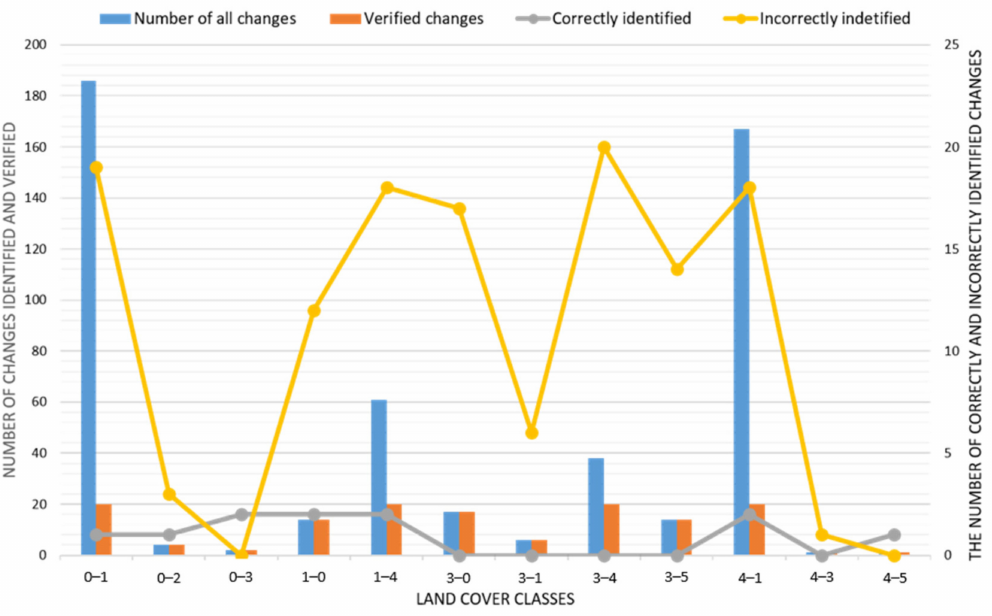
Figure 15. Results of qualitative accuracy